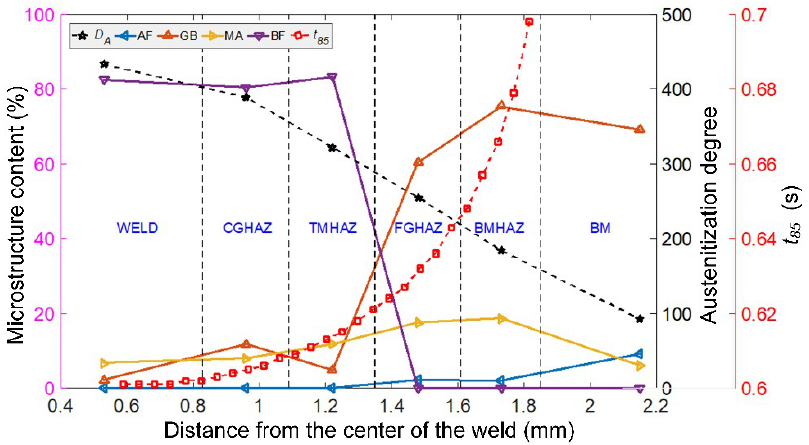
Figure 8. Quantitative relationship between the degree of austenitization and t 8 / 5 and the microstructure distribution in the laser-welded joint of X100 pipeline steel.